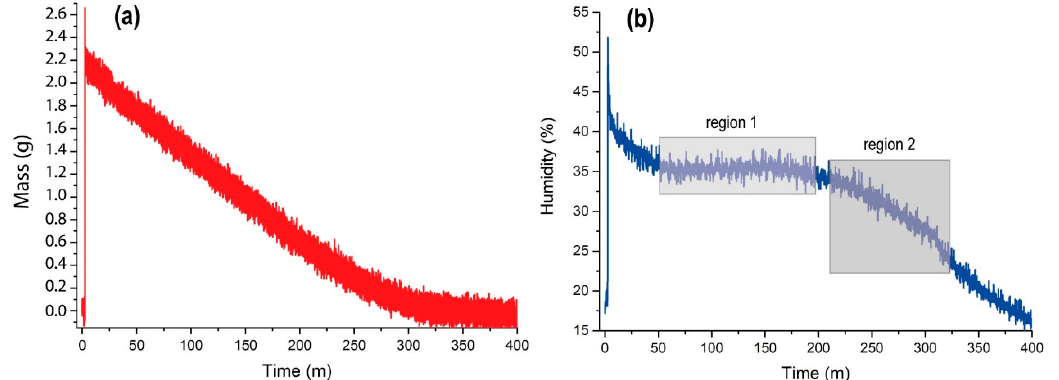
Figure 6. ( a ) Mass measurement of water injected and evaporated in 1 pulse of 1 s. ( b ) Relative humidity in the vacuum chamber during injection and evaporation. Region 1 shows the time in which the water sheet loses volume and the evaporation area and relative humidity remain constant. Region 2 shows the loss of volume and evaporation surface of the water layer decreasing the relative humidity.